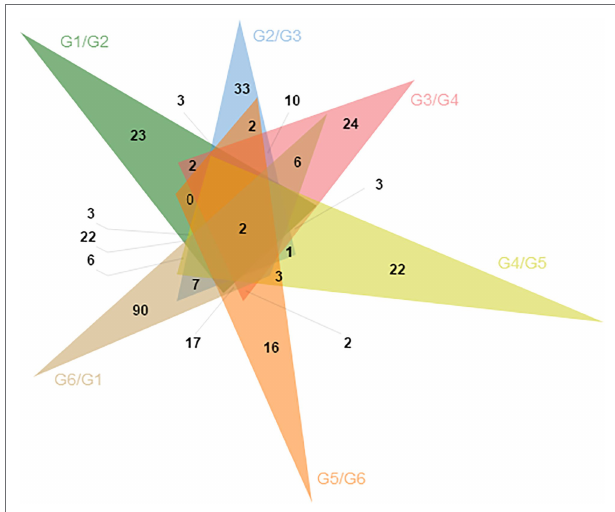
FIGURE 3 | The Venn of differential methylation genes in the six group comparisons.